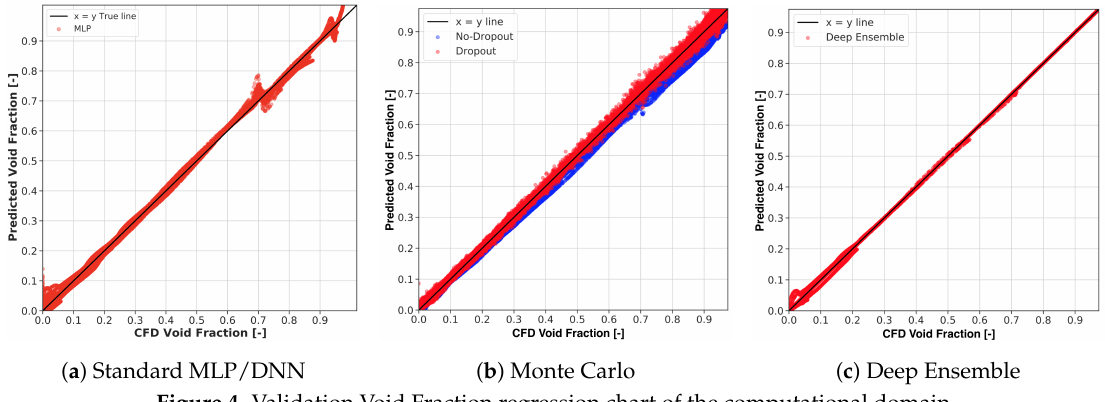
Figure 4. Validation Void Fraction regression chart of the computational